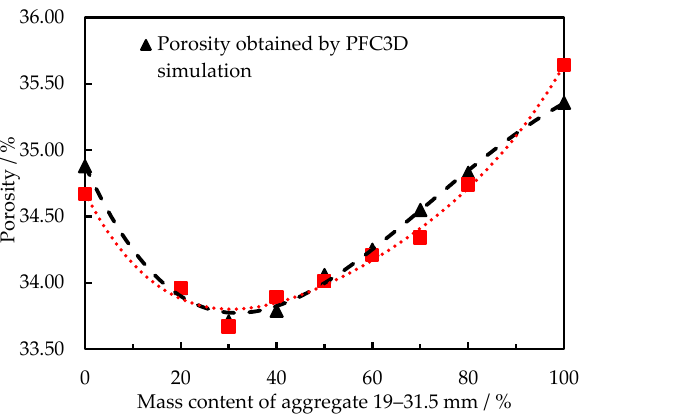
Figure 7. Fitting results of 19 – 31.5 mm aggregate and 9.5 – 19 mm aggregate porosity in different mass proportions.